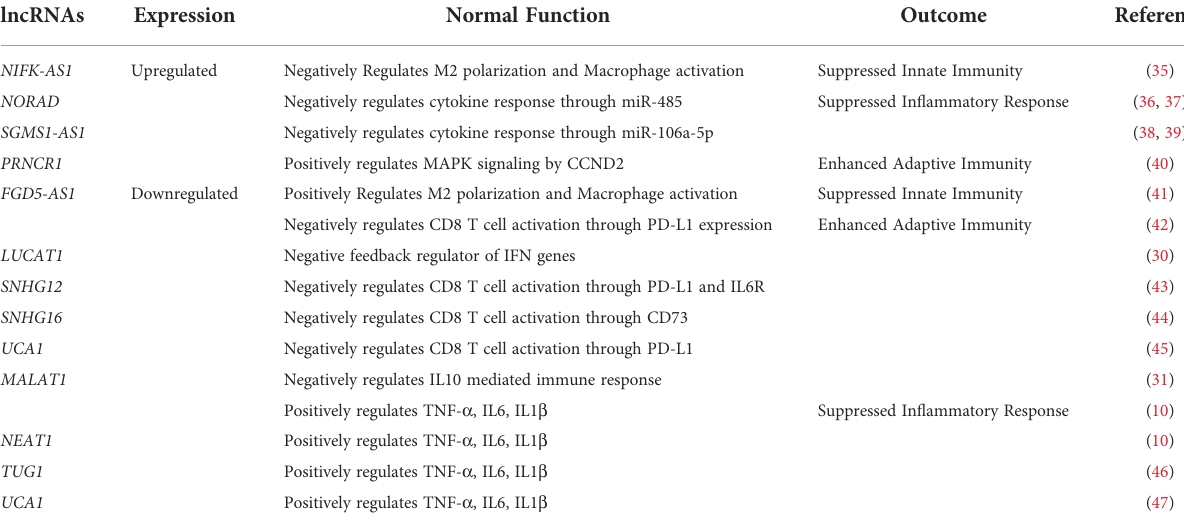
TABLE 1 Functional role of the DE lncRNAs in the Immune and In fl ammatory response.